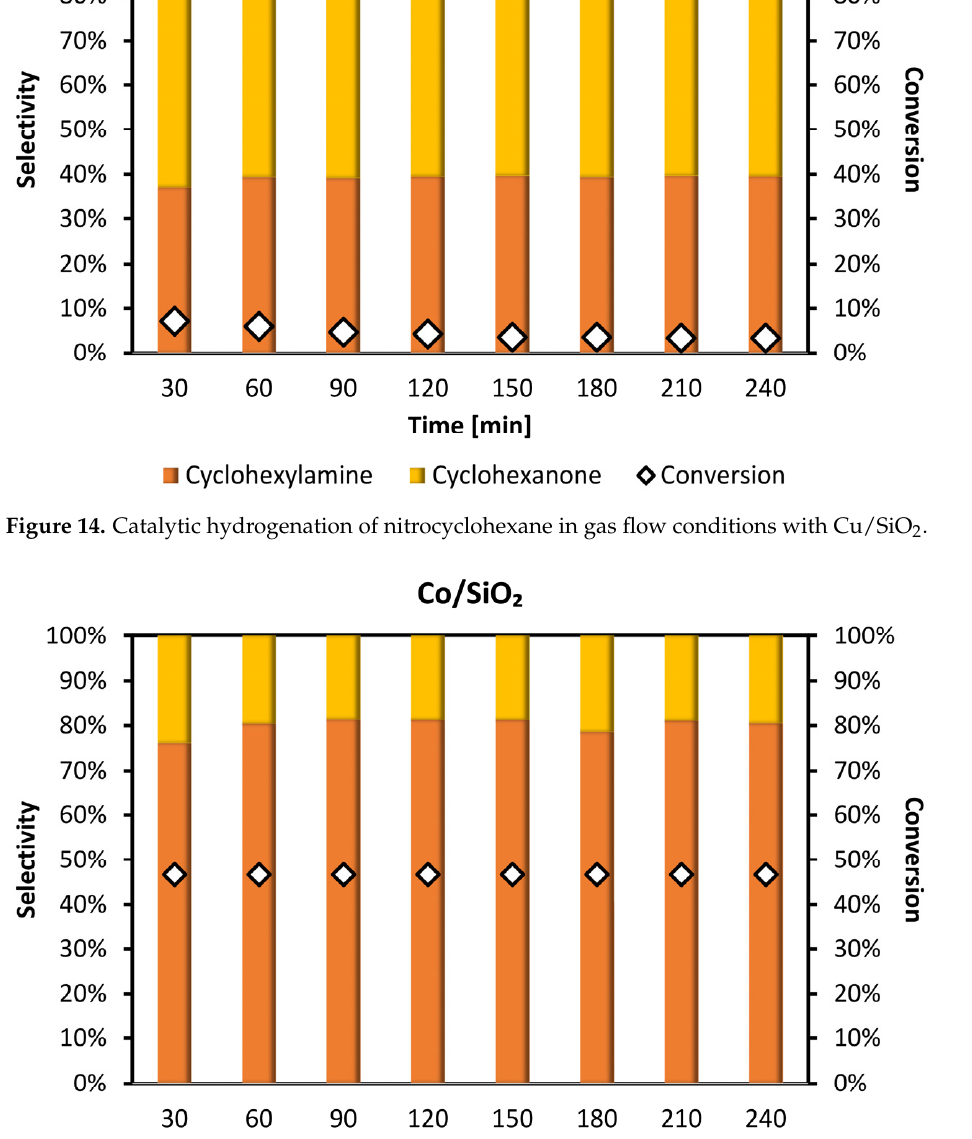
Figure 15. Catalytic hydrogenation of nitrocyclohexane in gas flow conditions with Co/SiO 2 . The results obtained for bimetallic catalysts are different from monometallic